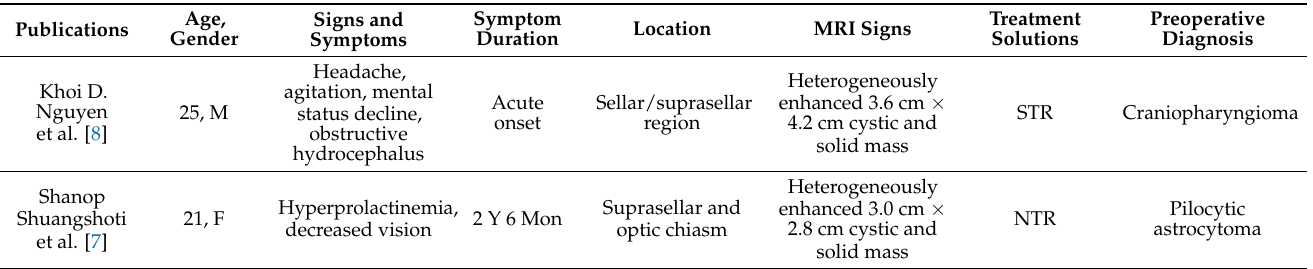
Table 1. Reported cases of suprasellar